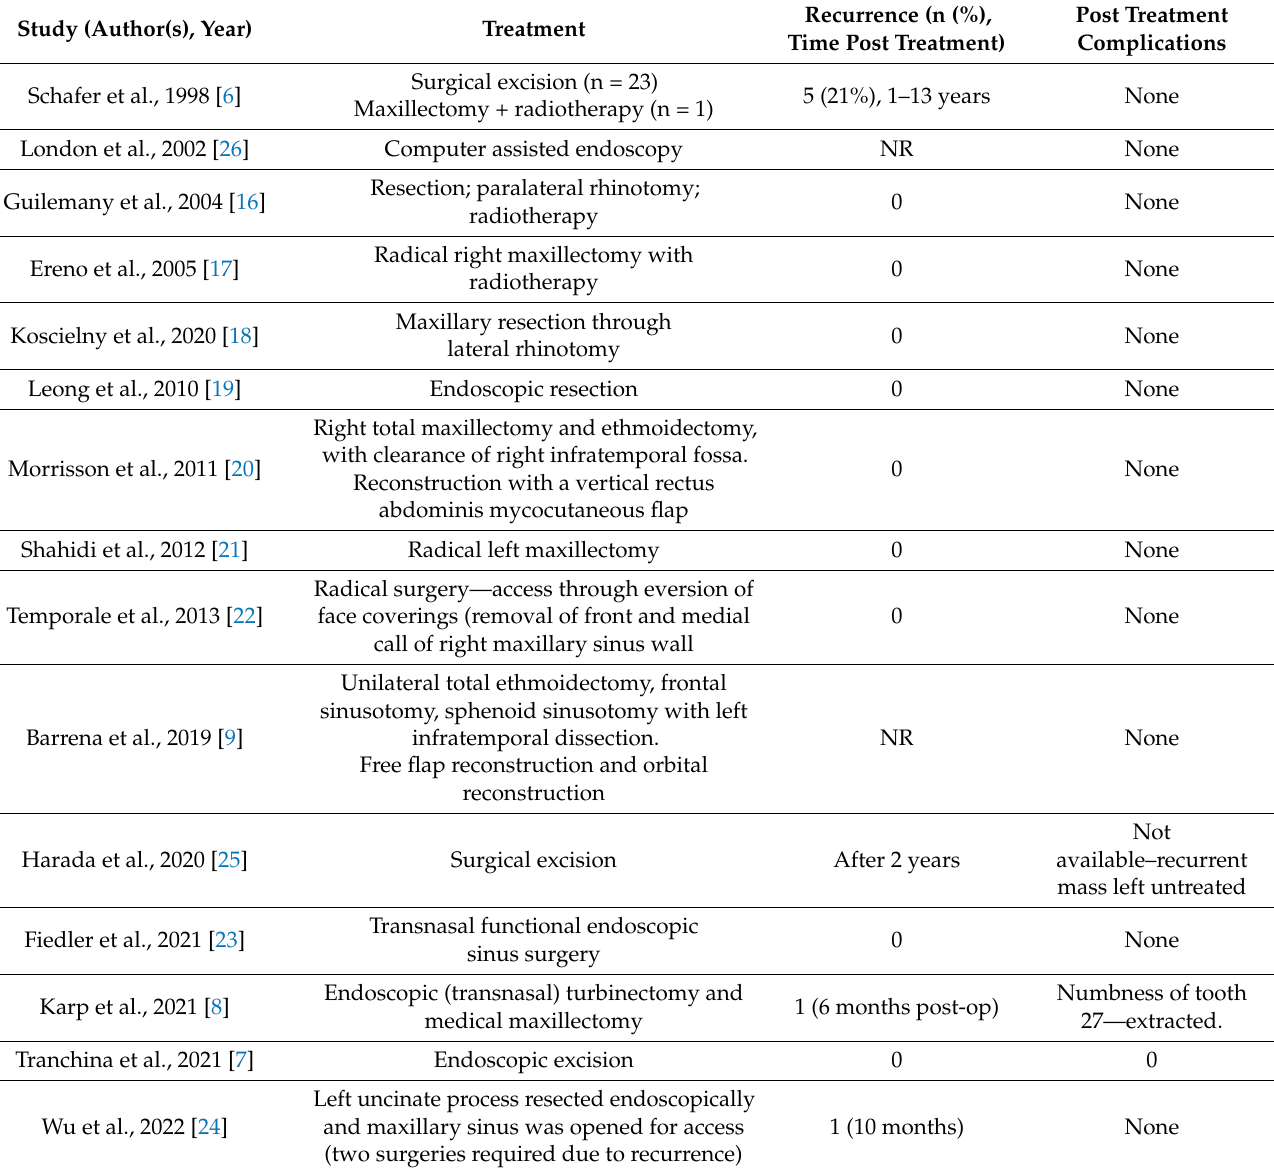
Table 2. Treatment, recurrence rate and post-op complications of included